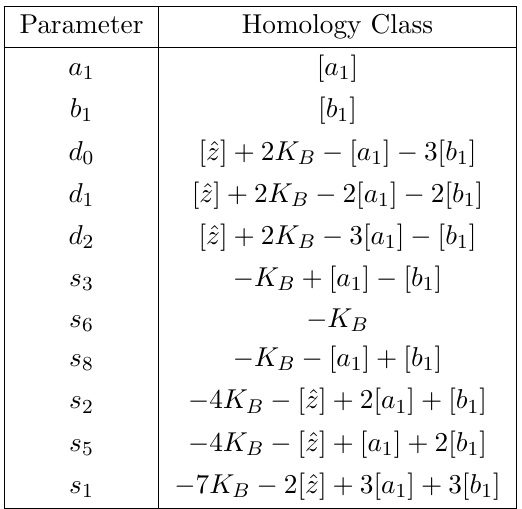
Table 4 . Homology classes for parameters in the q = 4 model. The classes are written in terms